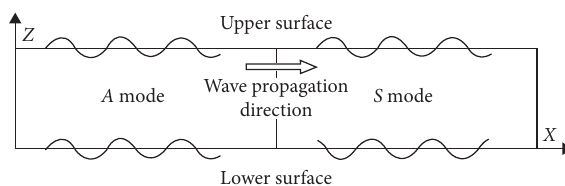
Figure 4: The characteristics of particle motions and deformations for S and A